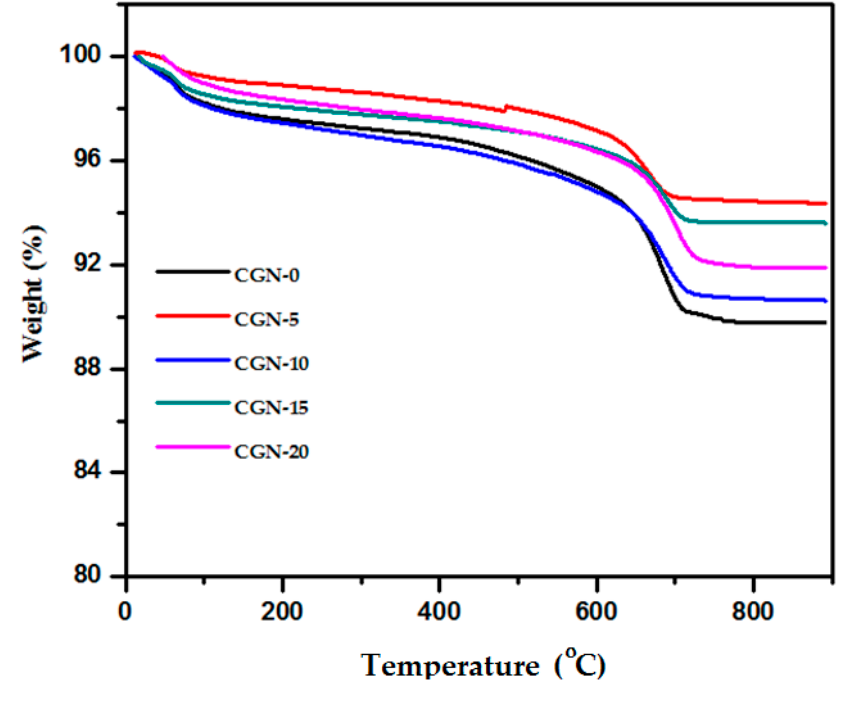
Figure 6. TGA of prepared mortar samples.